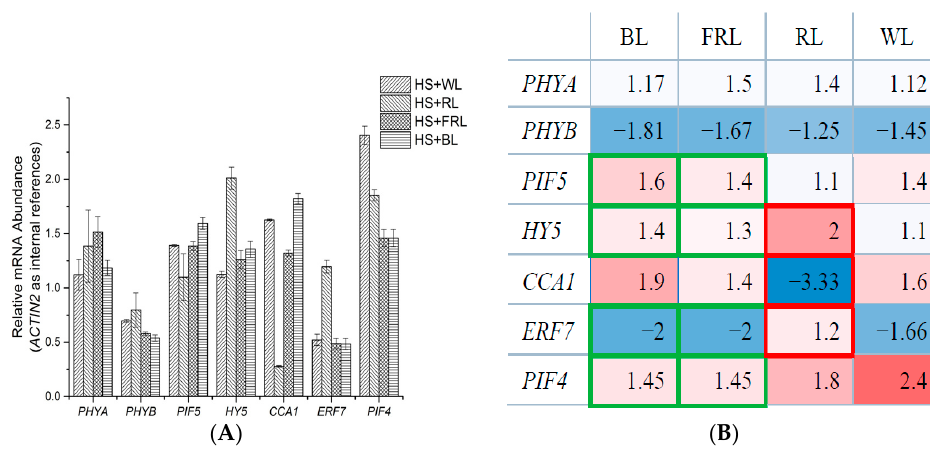
Figure 3. Transcriptomic response to HS, under different light conditions treatment (compared to control plants, ACTIN2 used as internal references). Plants grown at 23 °C are chosen as control. mRNA extraction and qPCR experiments are conducted as described in the method. HS + WL: Plants in this group are treated at 37 °C for 30 min, under white light. HS + RL: Treated at 37 °C for 30 min, under red light. HS + FRL: Treated at 37 °C for 30 min, under far-red light. HS + BL: Treated at 37 °C for 30 min, under blue light. WL, white light; RL, red light; FRL, far-red light; BL, blue light. The histogram ( A ) shows the expressions of genes in different light conditions; the table ( B ) demonstrated the similarity between BL and FRL groups (green frames), and the particularity of RL group (red frames). Blue shadow means the gene expression was repressed by HS. Red shadow means enhanced.